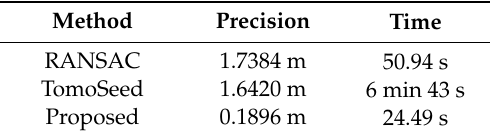
Table 2. Reconstruction precision and time cost obtained by a regular desktop PC (Core i5-7200U). A lower number indicates a better performance. The time does not include the time expended on data splitting and splicing in RANSAC and TomoSeed.